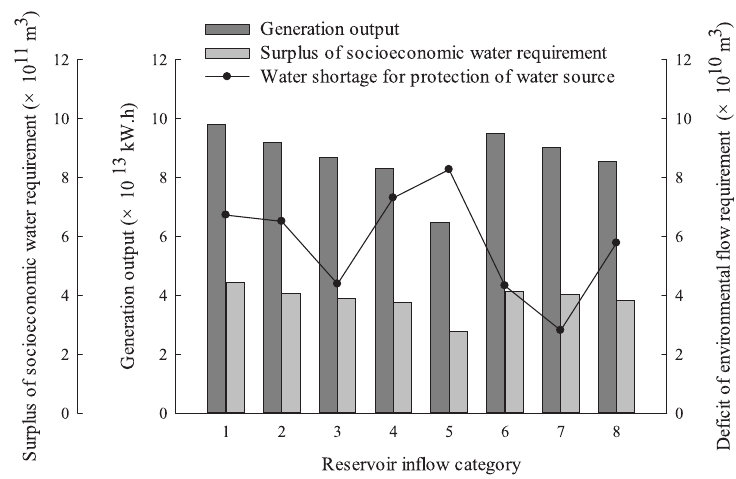
Figure 5. Objective values of the practical operation and multiobjective optimal operation of the TGR. (The reservoir inflow categories from 1 to 5 correspond to the actual operation under exceedance probability from 0 to 100% in Table 2, and reservoir inflow categories 6, 7, and 8 correspond to the optimal operation under wet, normal, and dry years,